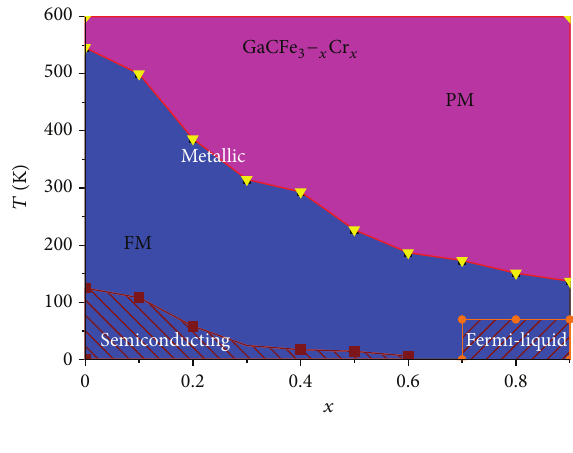
F 7: (Color online) e magnetic/electrical phase diagram for GaCFe